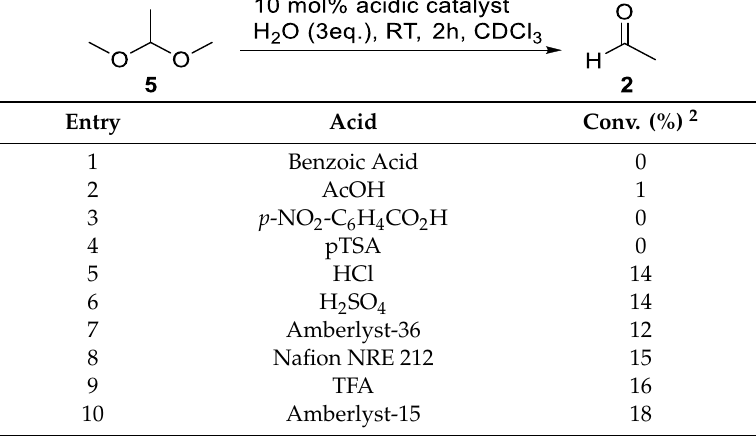
Table 1. Results of the acid-catalysed deprotection of acetaldehyde dimethyl acetal 1 .